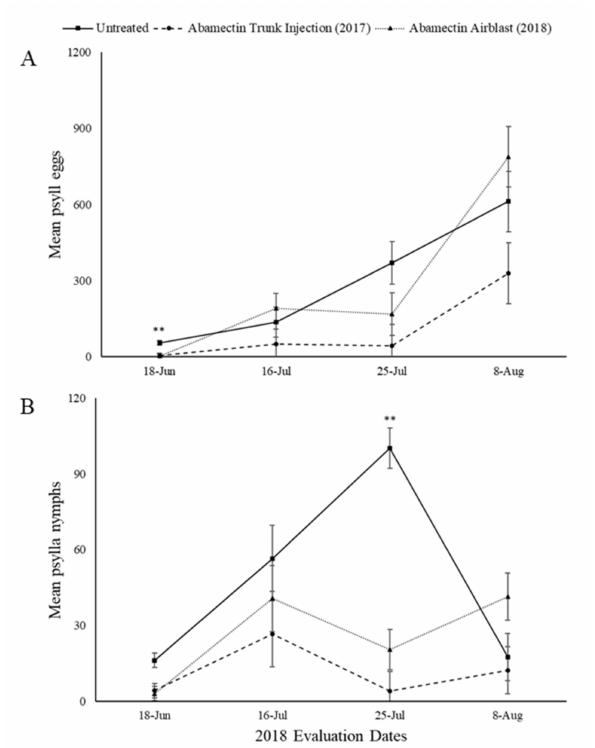
Figure 4. Mean number of pear psylla eggs ( A ) and nymphs ( B ) per 50 leaves in 2018 evaluations for the untreated and abamectin treatments. Values with ** above them represent a significant di ff erence ( p ≤ 0.05) between the untreated and both injection and airblast treatments.